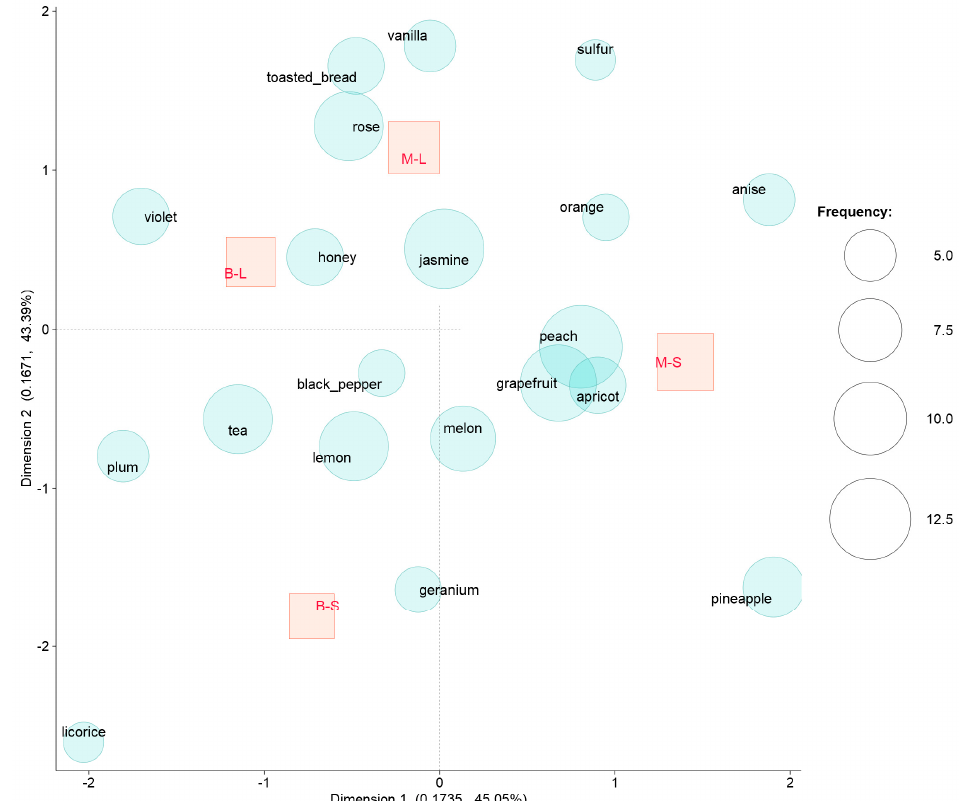
Figure 5. Correspondence analysis of the CATA attributes of the wines obtained by the combina- tion of grape cultivars (M—Minutolo, B—Bombino) and yeast starters (S— Saccharomyces cerevisiae , L— Lachancea thermotolerans ). Red squares correspond to wines, blue bubbles correspond to sensory attributes. Size of bubbles represents term